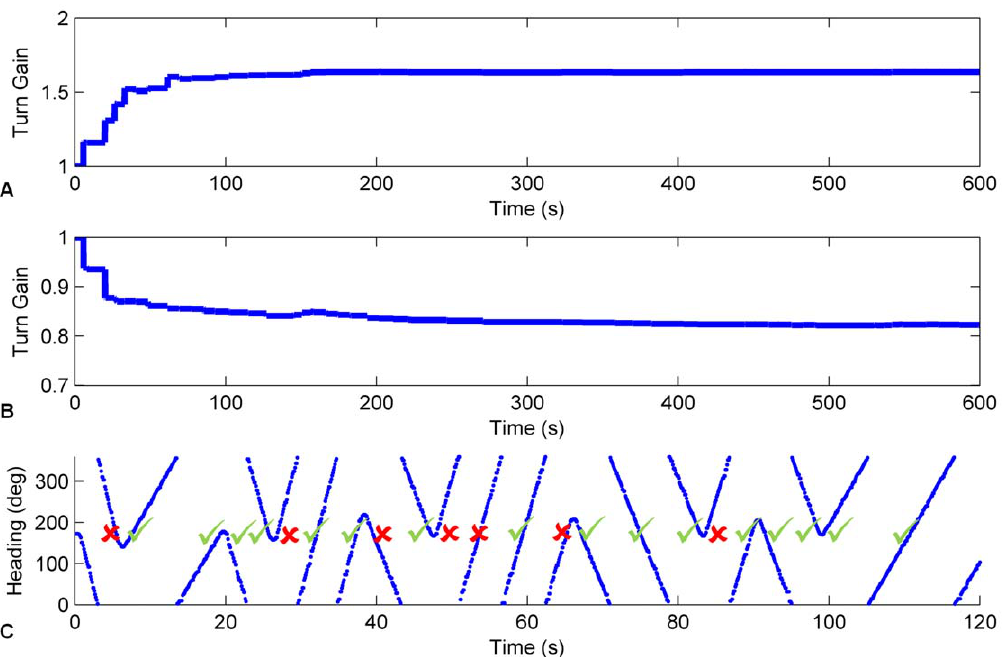
Figure 6. Turn gain converged rapidly for turns on the mobile robot platform. Convergence occurred despite unreliability of the visual tracking of the landmark that was used for calibration. Turn gain was increased when it started too low (A) and decreased when it started too high (B) as needed to reliably track robot heading. The bottom panel (C) shows the robot’s perceived heading to the landmark at each time point that the landmark was detected, during the first two minutes of training. Imperfections in the robot’s visual tracking of the landmark caused approximately 30% of the landmark alignments with 180 u (which should cause landmark reset of the HD bump) to be neglected in the first two minutes (red crosses in (C)). Despite the variable landmark tracking success, turn gain was quickly optimised, indicating robustness of the training.